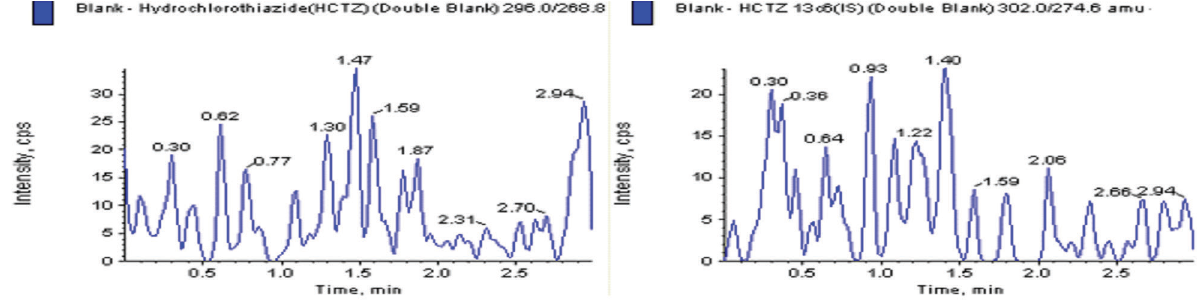
FIGURE 4 - Representative chromatogram of blank plasma sample-HCT.